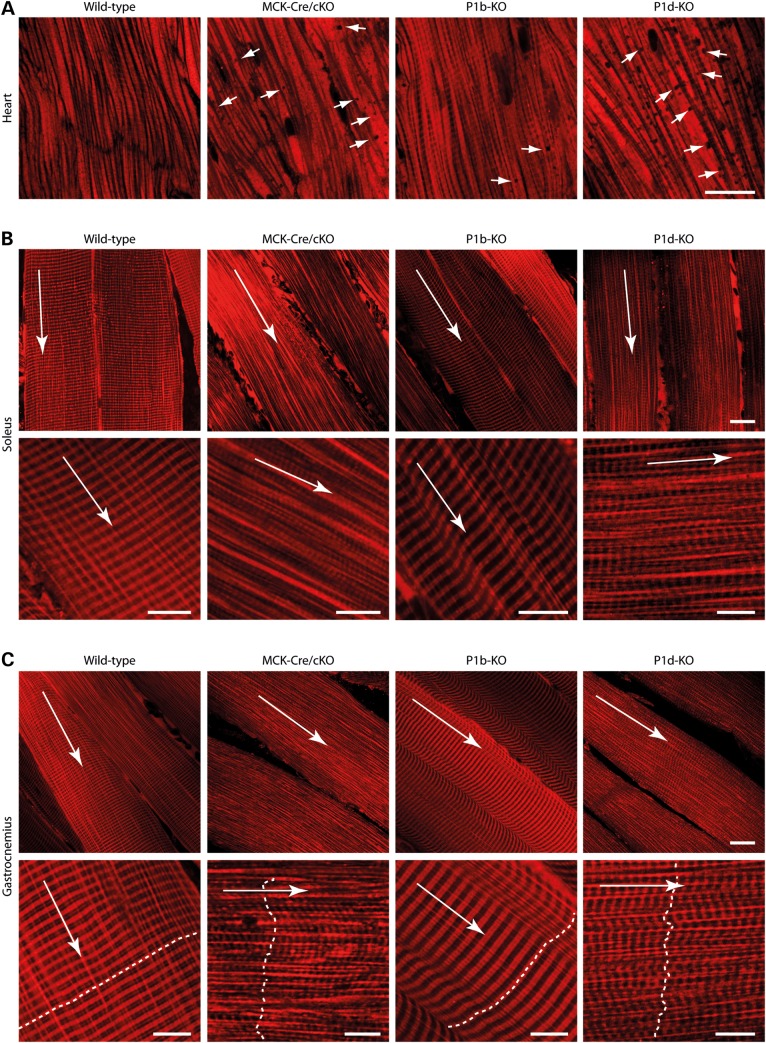
Alterations in mitochondrial morphology in plectin isoform-specific knockout tissues. Confocal images of MitoTracker-stained heart (A), soleus (B) and gastrocnemius (C) muscle tissues derived from wild-type, MCK-Cre/cKO, P1b-KO and P1d-KO mice are shown. In (B) and (C), data are presented as overviews (upper rows) and higher magnifications (lower rows). Long arrows, longitudinal orientation of skeletal muscle fibers. Dashed lines in (C), orientation and position of Z-disks. Note the alterations in mitochondrial positioning and morphology, including ‘black holes’ in the heart (arrows in A), in mutant compared with wild-type fibers. Scale bars: 20 µm (A–C, upper rows) and 10 µm (B and C, lower rows).